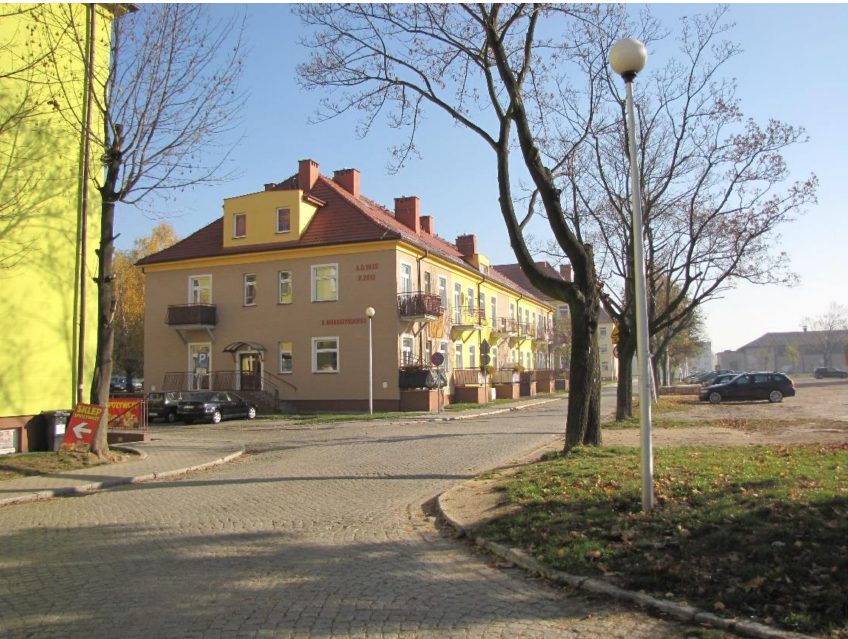
Figure 10. One of the buildings in Kasernen Siegeshöhe after revitalization (photo by M.